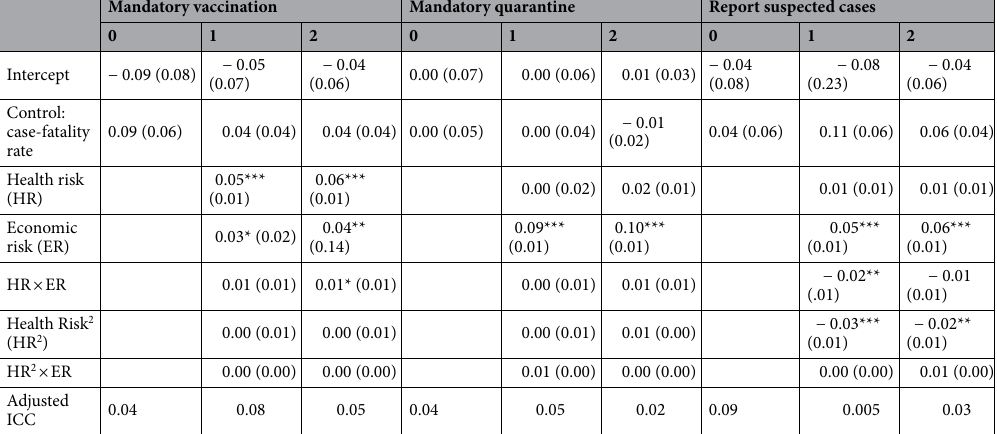
Table 2. Multilevel regression modeling: support for strict containment measures. Reporting unstandardized coefficients, standard errors in parentheses. * p < .05, ** p < .01, *** p < .001. All predictors are presented in “Materials and methods” section and detailed in Table S1. All models controlled for COVID-19 case-fatality rate: total COVID-19 deaths per million/ total COVID-19 cases per million. Model 2 adjusted for individual and country level covariates as follows. Individual level covariates: (1) direct exposure to someone in their personal network (self, family, friends) infected with COVID-19; (2) perceived knowledge about the COVID- 19, (3) perceived knowledge about the economic consequences of the COVID-19; (4) the perceived quality of the public messages received, (5) community norms about mitigation measures, and (6) sociodemographic variables (age, gender, education, employment and financial status). Country-level covariates included (1) total population of the country (in millions), (2) gross domestic product (GDP) per capita (in current $US), (3) unemployment rate estimates for 2020 (as % of the labor force), (4) old age dependency ratio (%), (5) Gini Index, (6) general health expenditure (as %GDP), (7) private health expenditure (as % health expenditure), (8) out-of-pocket health payments (as % health expenditure), (9) number of hospital beds (per 1000